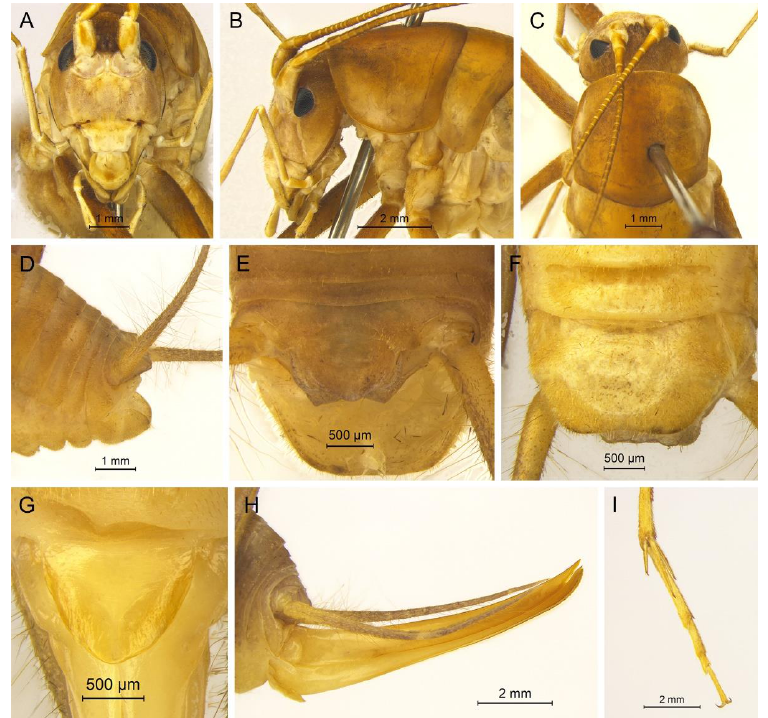
Figure 4. Gymnaetoides huangshanensis Zhu & Shi sp. nov., male: ( A – C ) head and pronotum: ( A ) frontal view, ( B ) lateral view, ( C ) dorsal view; ( D – F ) apex of abdomen: ( D ) lateral view, ( E ) dorsal view, ( F ) ventral view; ( I ) hind tarsus in lateral view; female: ( G ) subgenital plate in ventral view; ( H ) ovipositor in lateral view. Posterior margins of all abdominal tergites straight. Epiproct ligulate, paraproct tri- angular in lateral view. Cercus slender, conical, apex acute. Dorsal sclerite of genitalia quadrangular, basal area broad, with concavity, apical area slightly concave; basal area of dorsal median lobe with paired lateral sclerites, nearly semicircular, apical area divided into two lobes; dorsal lateral lobes broad, nearly equal in length to dorsal median lobe, apical area sclerotized, spinous; ventral lateral lobes tiny, much shorter than dorsal lateral lobes; ventral median lobe short. Subgenital plate quadrangular, transverse and wide, posterior margin slightly concave. Female: Appearance is similar to male. Ovipositor longer than half the length of hind femur, slightly curved upward, dorsal margin smooth, apical area of ventral margin den- ticulate. Subgenital plate triangular, apex obtuse. Coloration. Body yellowish brown, uniform. Eyes black, ocelli yellow. Measurements (mm). Body: ♂ 10.9 – 13.8, ♀ 9.5 – 11.6; pronotum: ♂ 4.1 – 4.5, ♀ 3.5 – 3.8; fore femur: ♂ 9.3 – 10.0, ♀ 8.0 – 8.4; hind femur: ♂ 16.5 – 18.6, ♀ 13.8 – 14.6; hind tibia: ♂ 17.7 – 19.2, ♀ 14.8 – 16.0; hind basitarsus: ♂ 4.3 – 4.4, ♀ 3.3 – 3.7; ovipositor: 8.6 – 9.5. Distribution. China (Anhui). Gymnaetoides indivisus (Zhang & Liu, 2009) Diestrammena ( Gymnaeta ) indivisa Zhang & Liu, 2009: 26. Gymnaetoides indivisus : Qin, Liu & Li, 2017: 188.